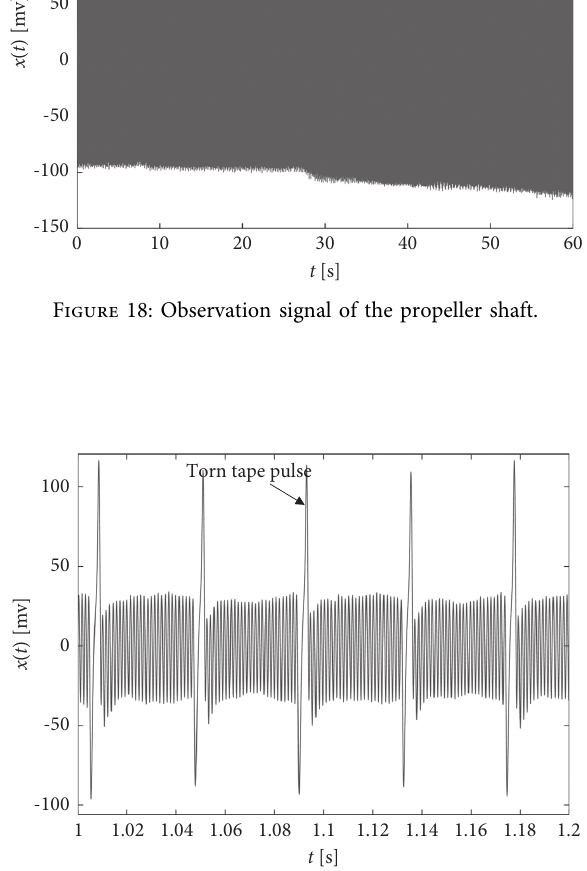
Figure 19: Amplified observation signal of the propeller shaft.